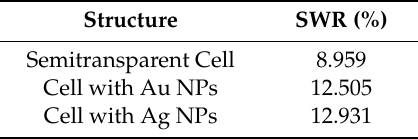
Table 4. SWR data for the three di ff erent cell structures.